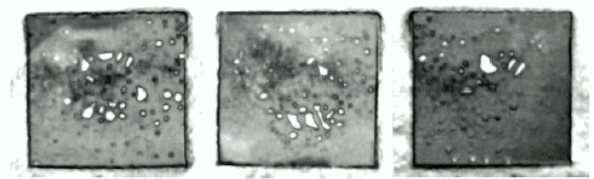
Figure 15. Scanning acoustic microscopy images of the die-attach solder of S1 (left), S2 (center), and S3 (right).